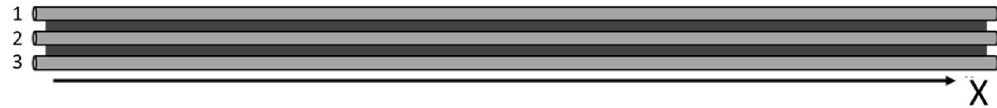
Figure 6. Schematic of the metamaterial composed of a parallel array of three coupled